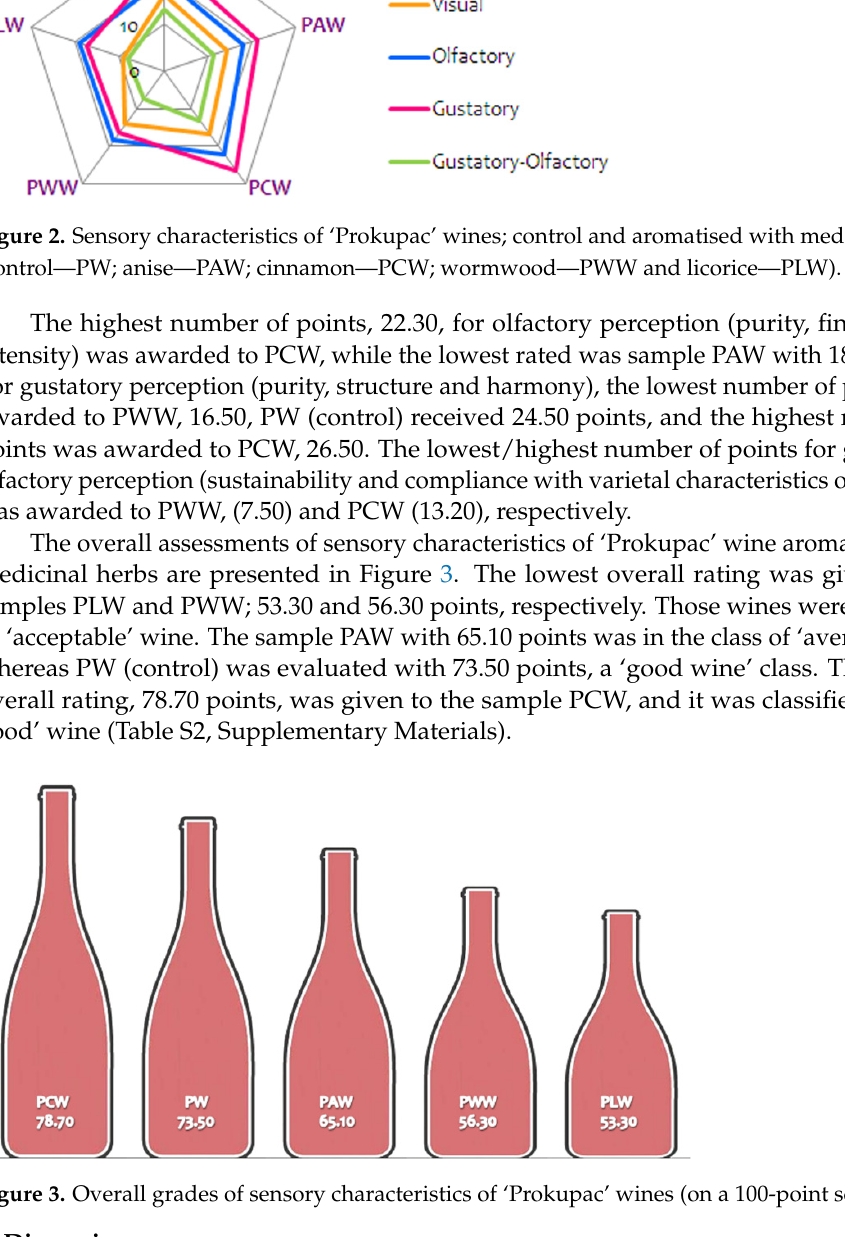
Figure 3. Overall grades of sensory characteristics of ‘Prokupac’ wines (on a 100-point scale).